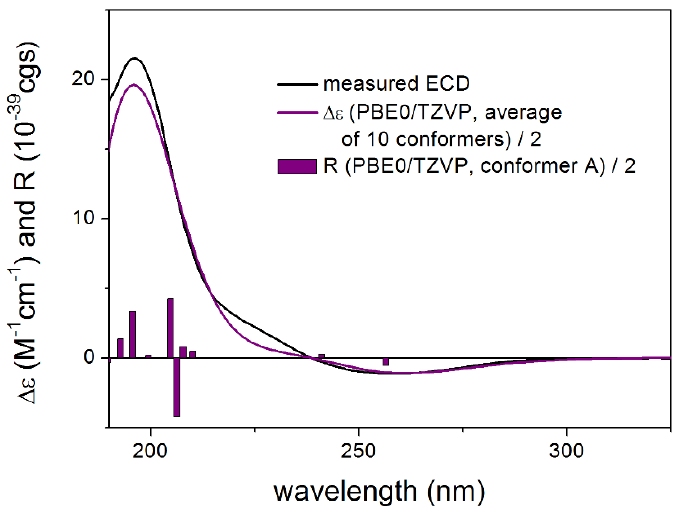
Figure 11. Comparison of the experimental ECD spectrum of 6 measured in MeCN with the PBE0/TZVP PCM/MeCN spectrum of (1 R ,3 S ,6 R ,7 R ,8 R ,10 R )- 6 (level of optimization: CAM-B3LYP/TZVP PCM/MeCN). The bars represent the rotational strength values of the lowest energy conformer.